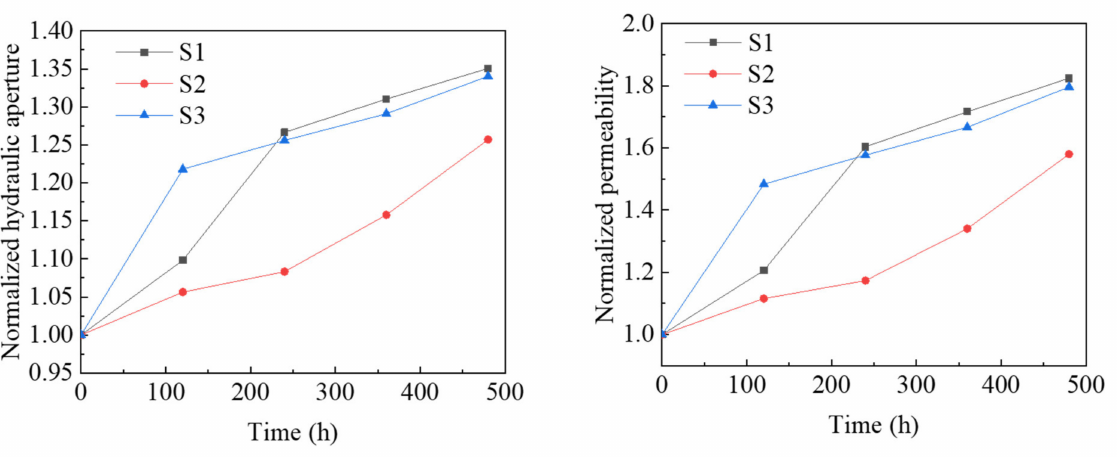
Figure 16. Temporal evolutions in fracture normalized hydraulic aperture ( left ) and permeability ( right )